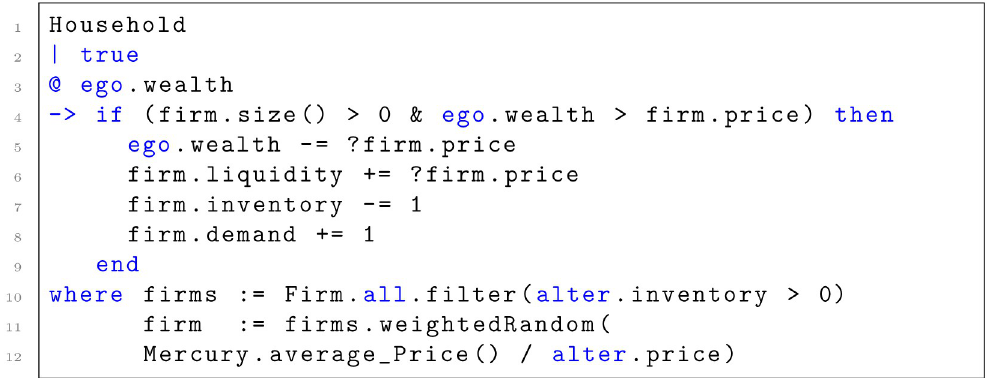
Fig 5. Household consumption rule in ML3. Note: The Figure shows the demand rule, modeling household consumption or expenditure of financial wealth in exchange for homogeneous goods from firms. “Mercury” is an auxiliary agent, which otherwise has no interactions with other